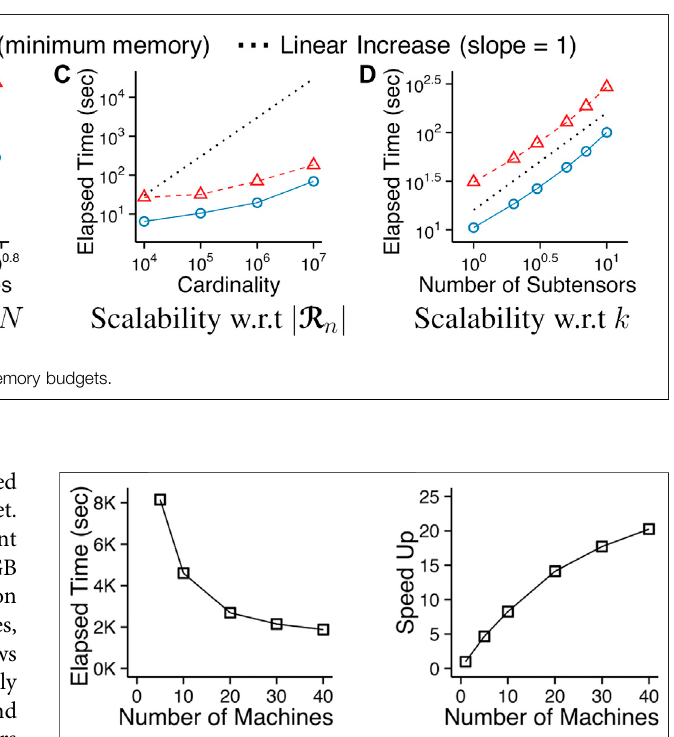
FIGURE 6 | D-CUBE scales out. The MAPREDUCE implementation of D-CUBE is speeded up 8 × with 10 machines, and 20 × with 40